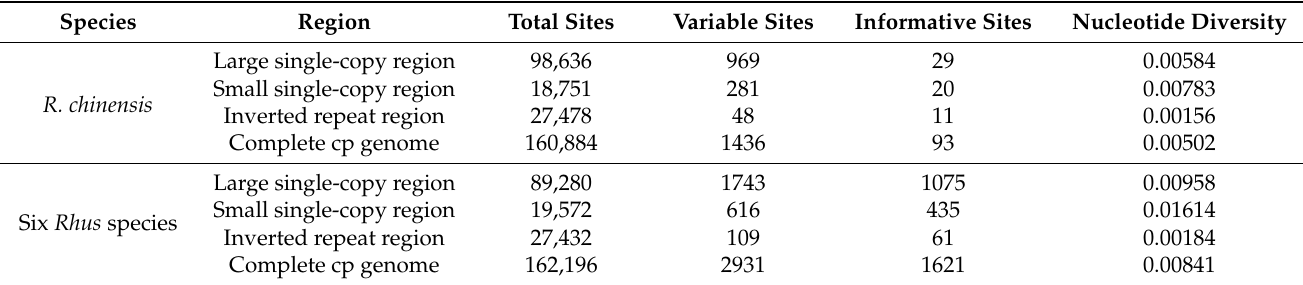
Table 4. Variable site of complete chloroplast genomes of four R. chinensis accessions and six Rhus